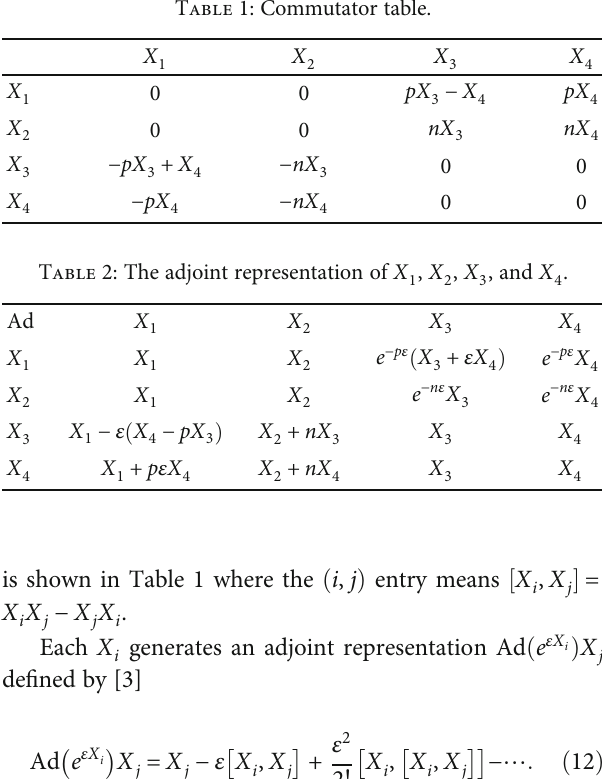
Table 1: Commutator table.